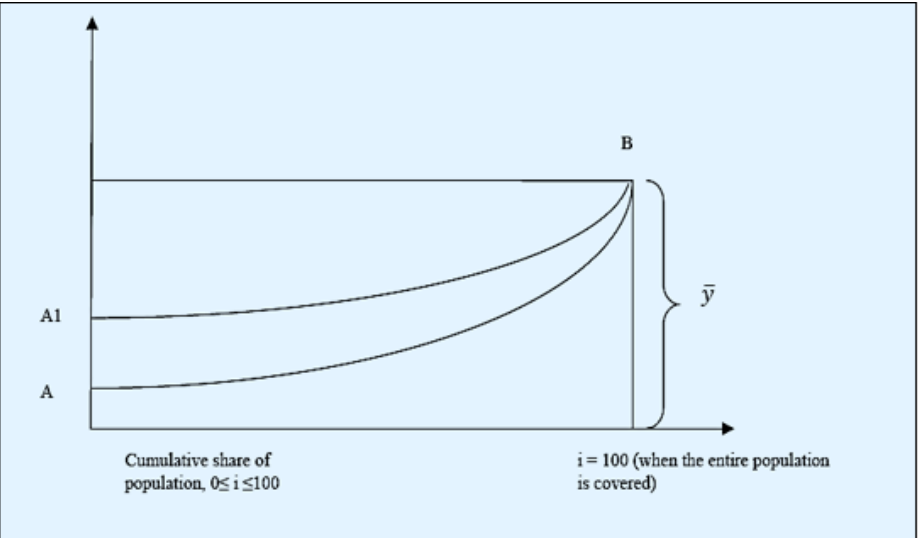
Figure 1: Social Mobility